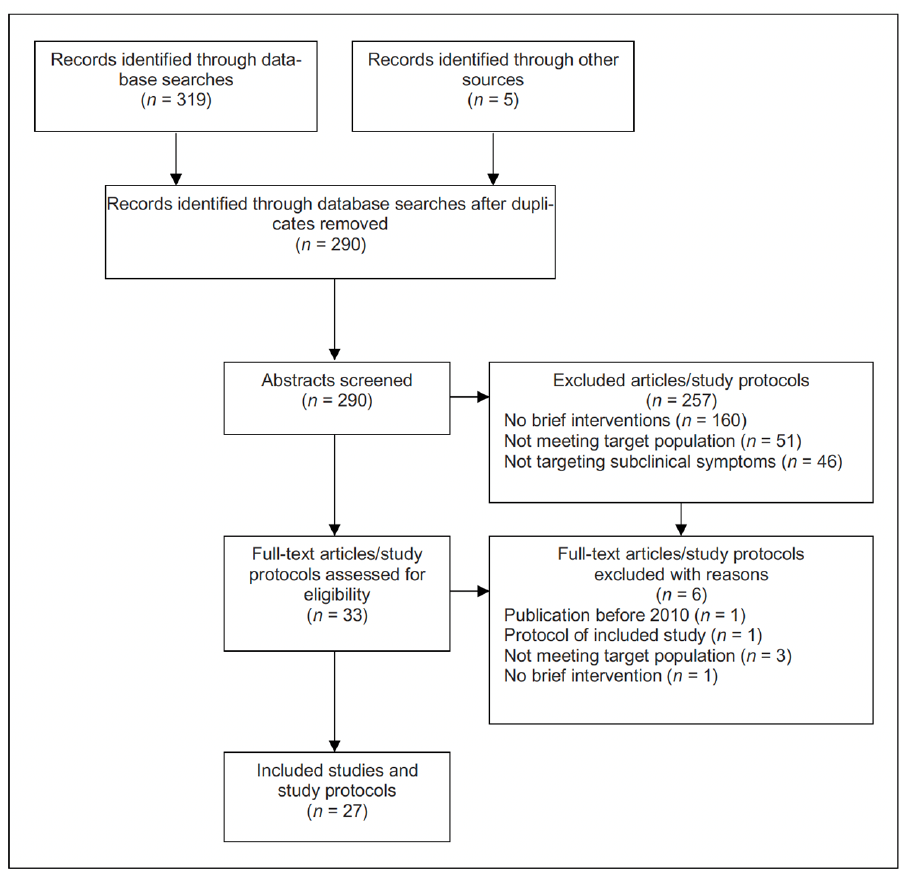
Figure 1. Flowchart of the review process .